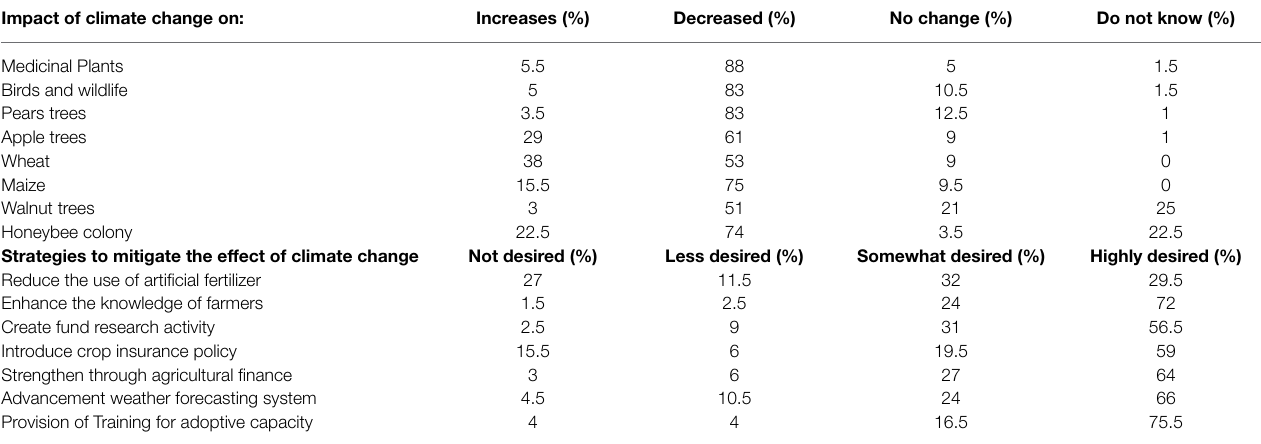
TABLE 4 | Impact of climate change on indigenous yield and mitigating strategies by the farmers. Impact of climate change on: Increases (%) Decreased (%) No change (%) Do not know (%) Medicinal